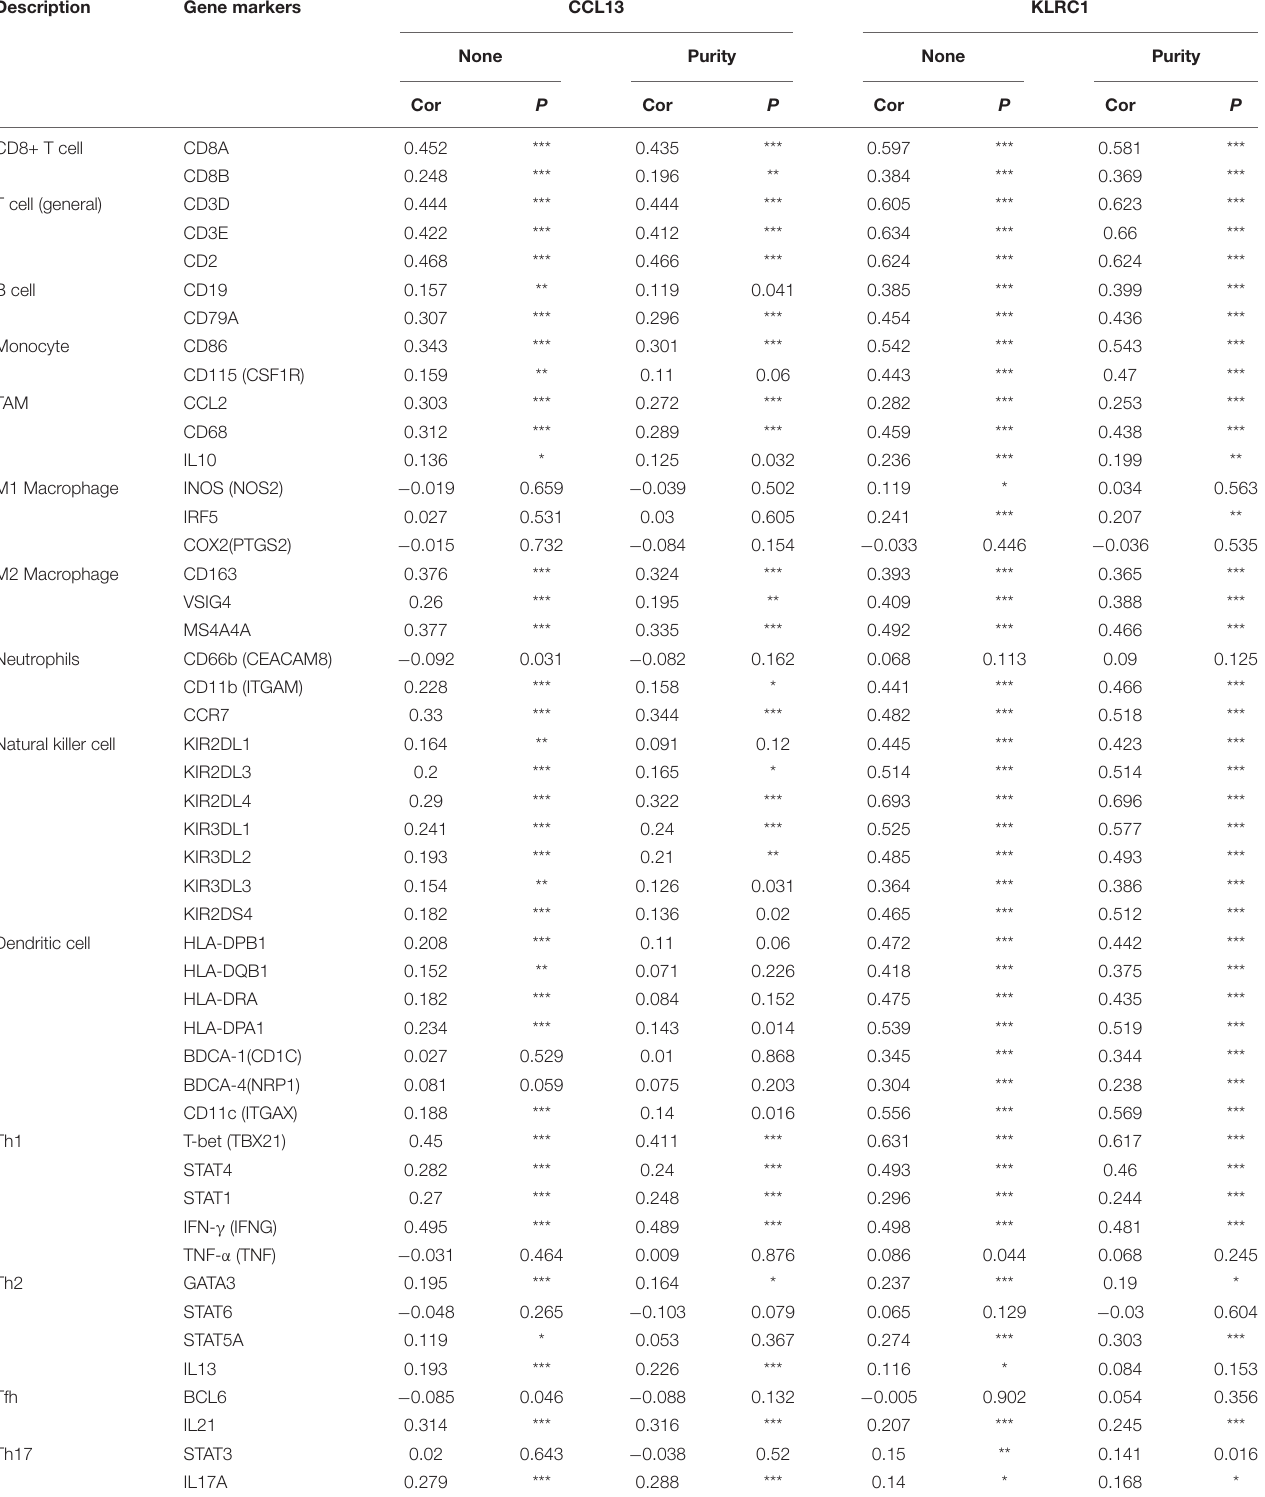
TABLE 3 | Correlation analysis between two hub genes and immune cells markers in TIMER. Description Gene